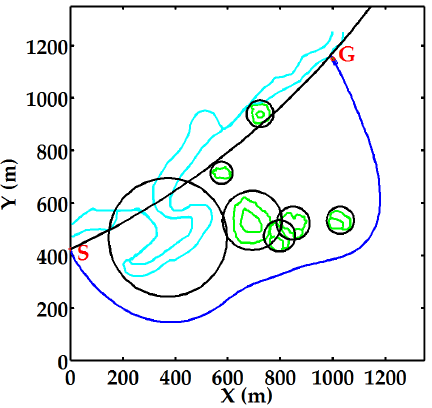
Figure 12. The simulation final result in the static sea